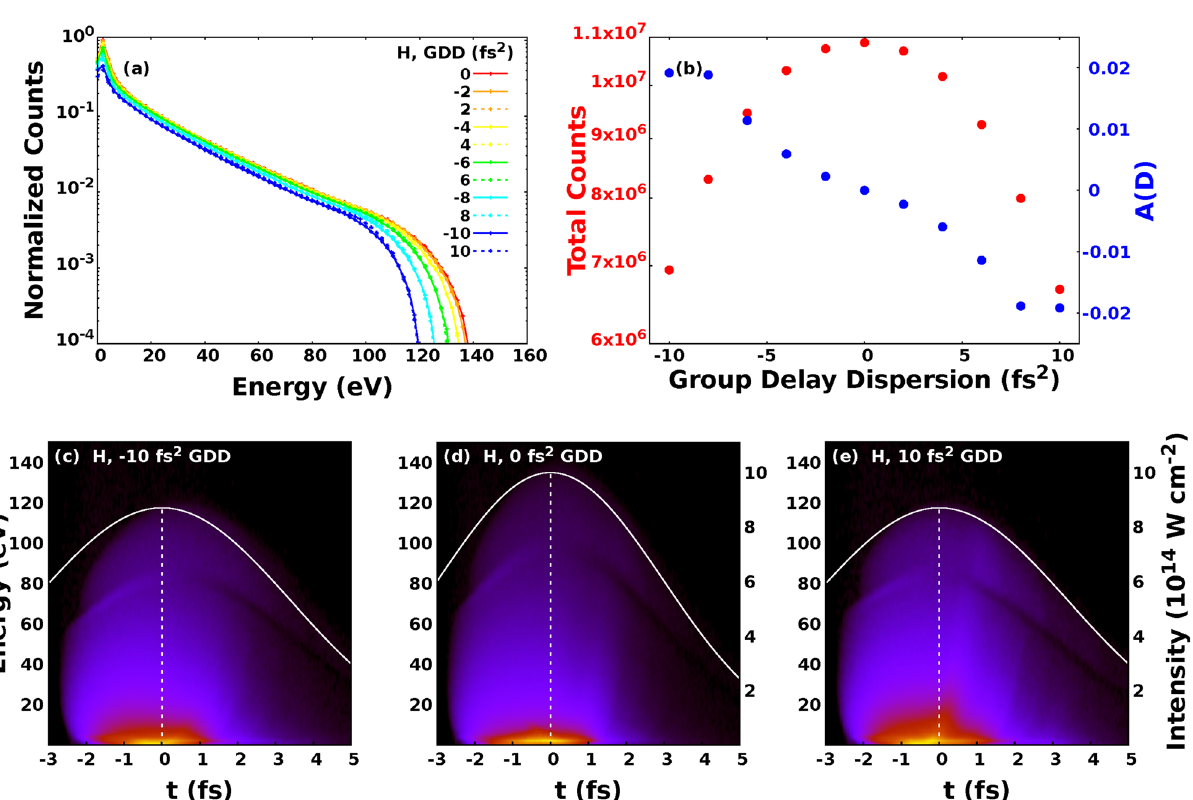
15 W / cm 2 Figure 6. Calculated photoelectron spectra for hydrogen at 10 intensity with different values of GDD ( a ) and the corresponding electron yield and asymmetry parameter ( b ) defined by Eq. (17). Contour plots of the square root of the normalized photoelectron distributions as a function of ionisation time and kinetic energy 2 2 2 with -10 fs ( c ), 0 fs ( d ) and 10 fs ( e ) GDD. The temporal envelope of the intensity of the laser pulse is depicted with a white line. The vertical dashed white line shows the moment of time when the intensity is